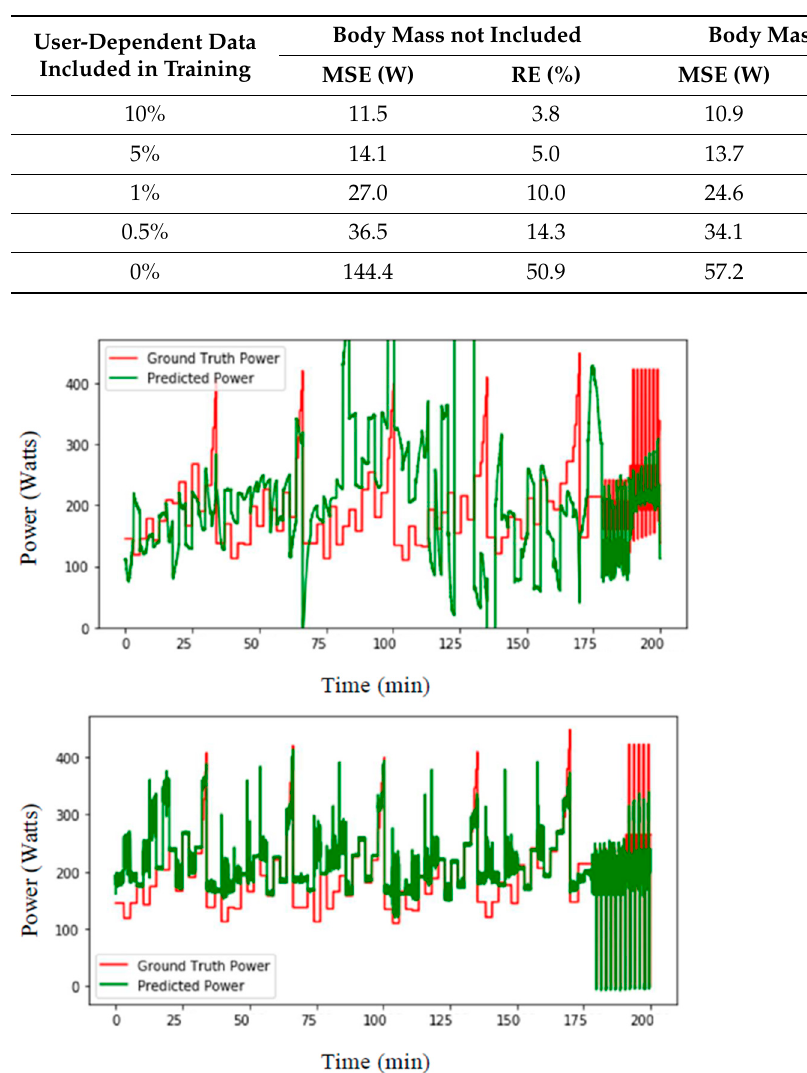
Table 1. Mean-squared errors (MSE) in watts (W) and relative error (RE) in % of the estimated power for partially user-dependent approach using Long Short-Term Memory LSTM with or without body mass included in the data.